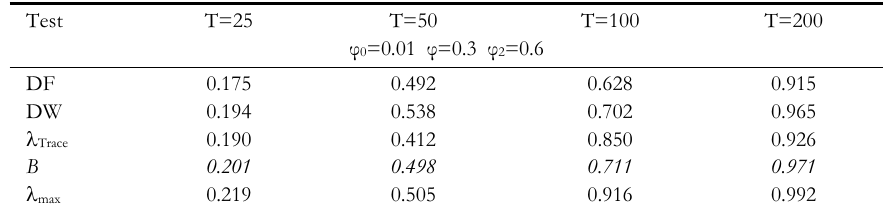
( (cid:438) 0 =0.1 (cid:438) =0.3 (cid:438) 2 =0.6) Estimation of the power of the tests, nominal level 0.95